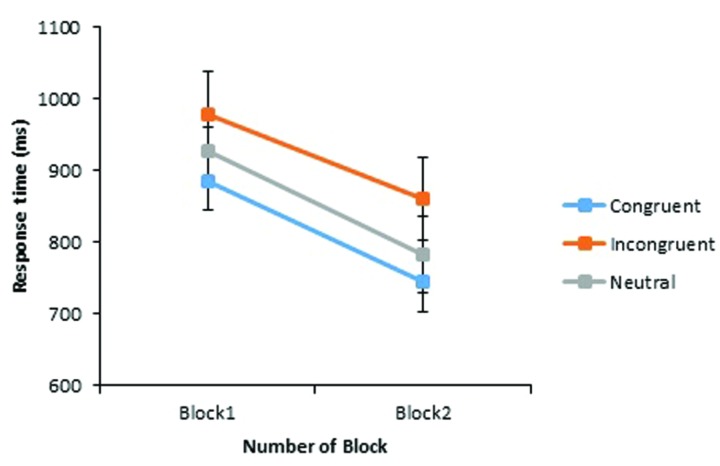
Experiment 2: mean response times (in milliseconds) of correct judgments to critical word pairs across Block 1 and Block 2. The vertical axis begins at 600 ms while error bars indicate the 95% confidence interval.